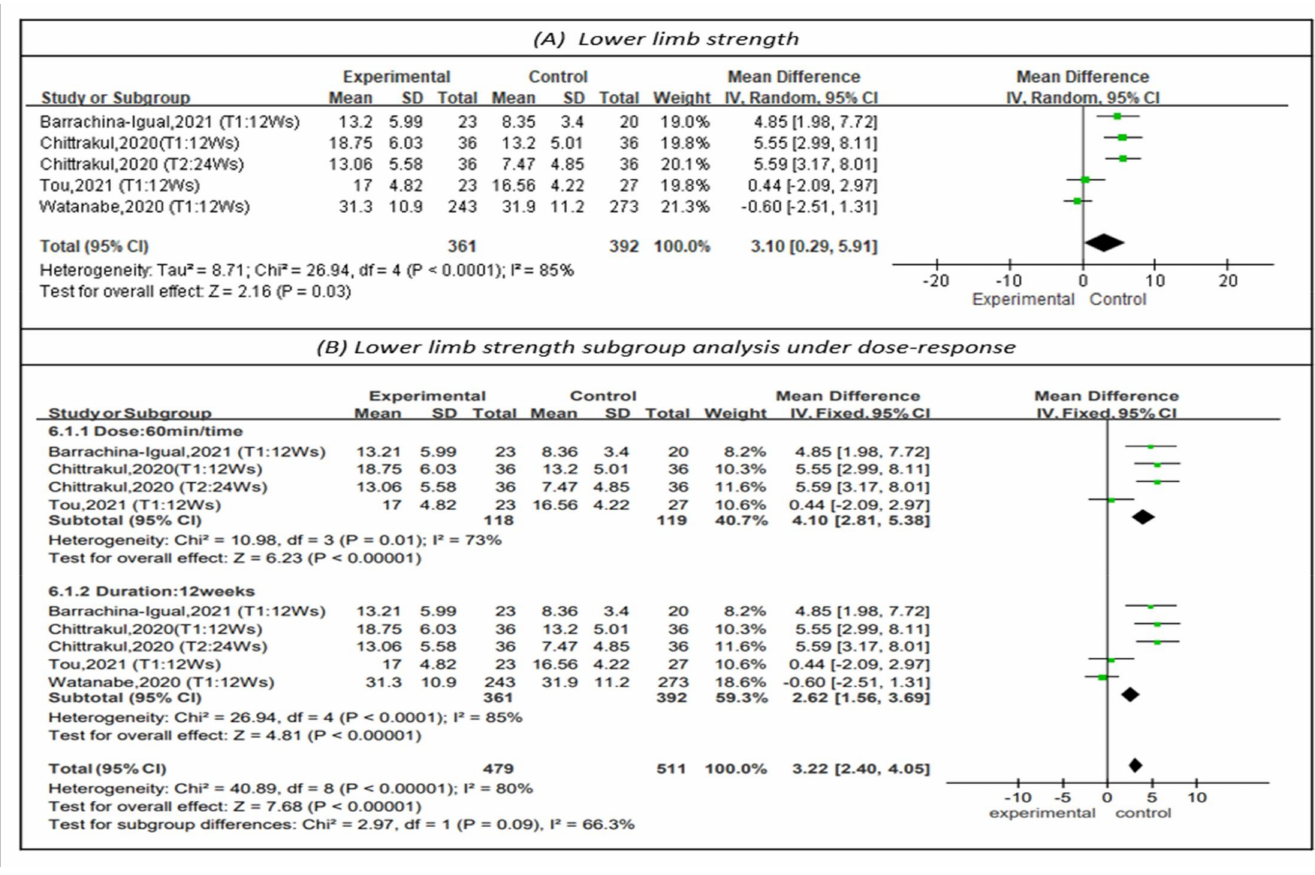
Figure 6. Forest plot of effects on lower-limb strength and subgroup analysis for dose-response. The size of the green square represents the weight of the study in the meta-analysis. The rhombus represents the combined OR. OR = odds